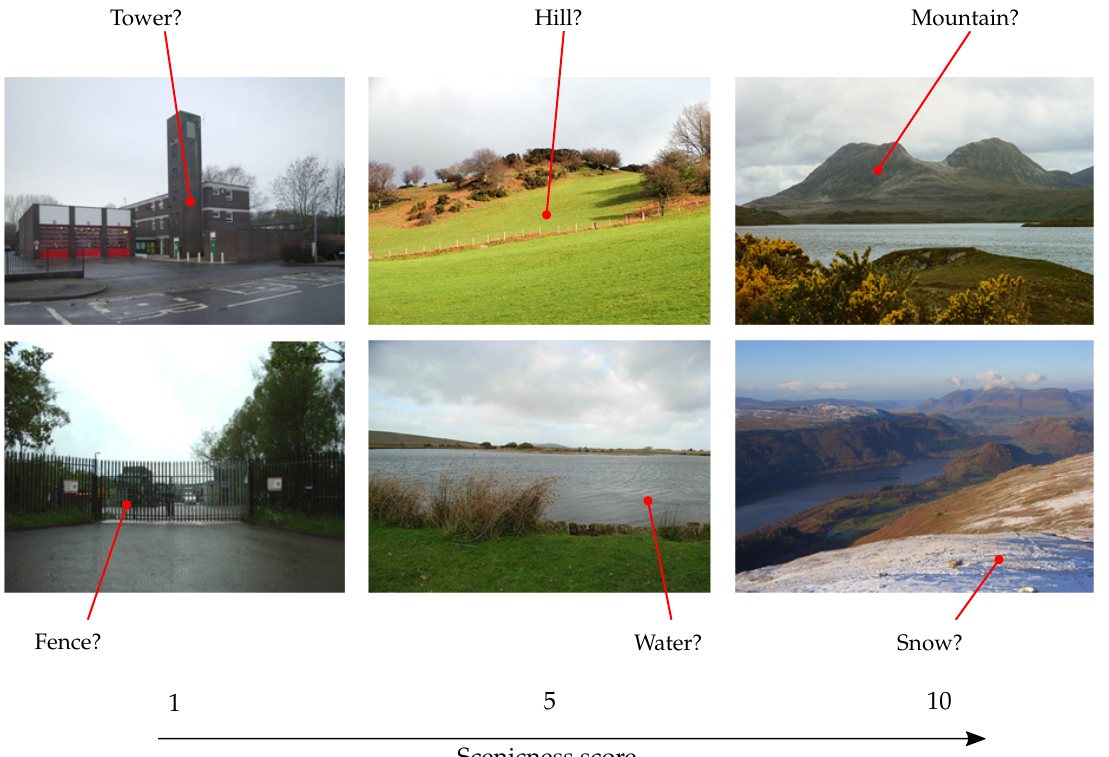
Figure 1. Images from the ScenicOrNot dataset, ranked from low scenicness ( left ) to high scenicness ( right ). In this work, we extract semantic concepts (water, snow, etc.) related to landscape